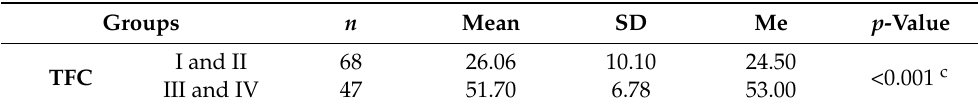
Table 4. Known-group validity of the 12-item WHODAS